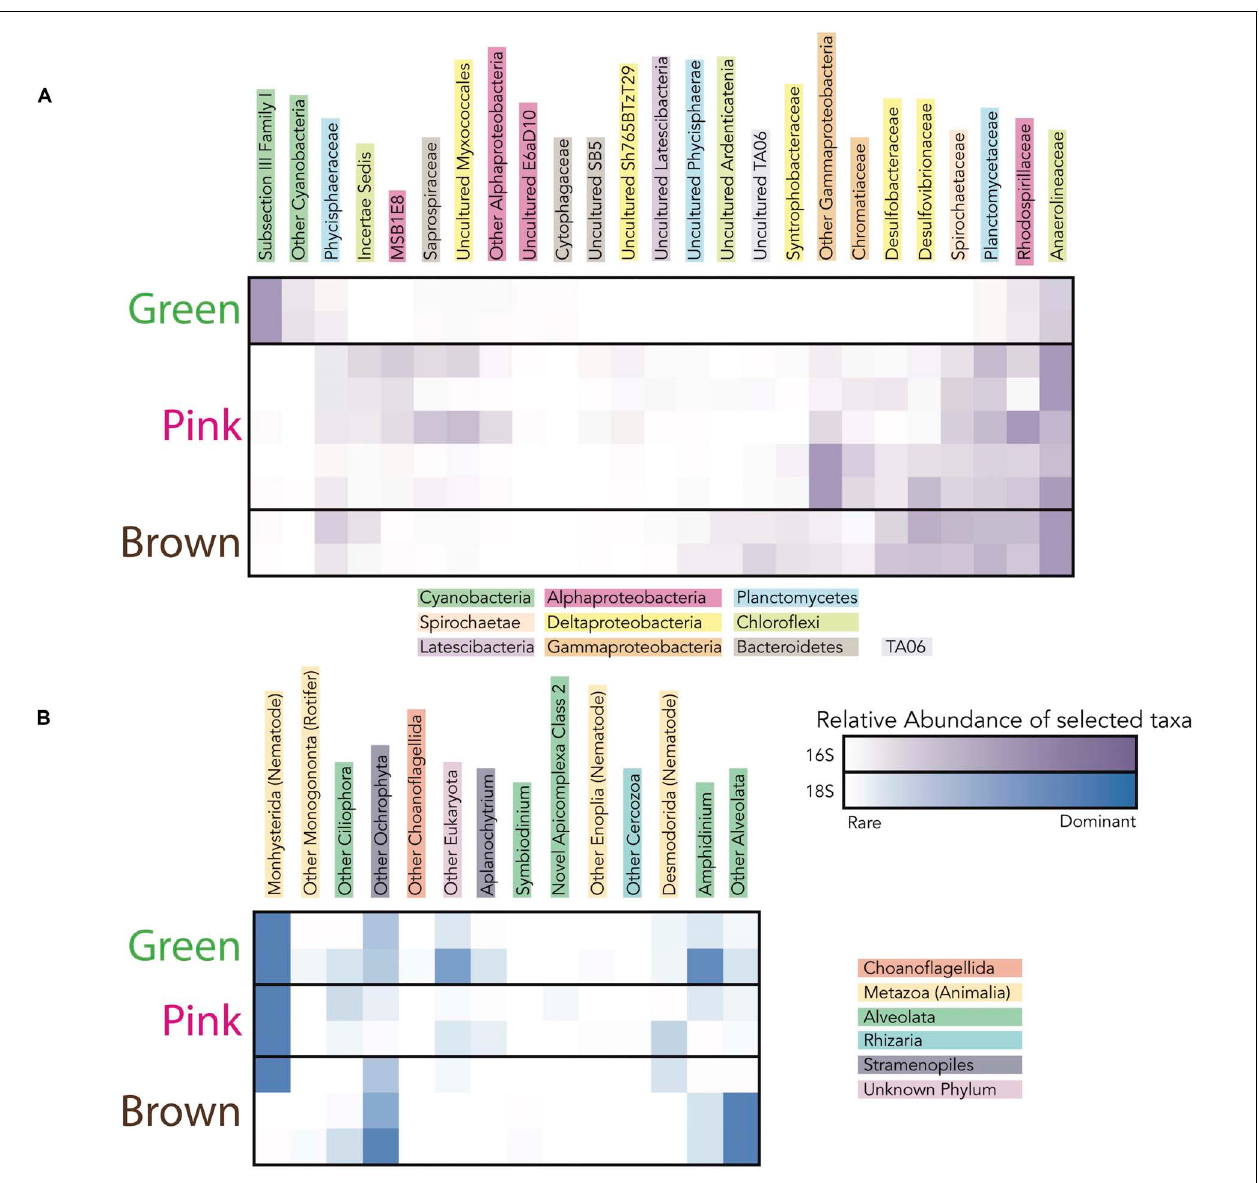
FIGURE 6 | Heatmap showing the taxa (i.e., operational taxonomic units clustered at the 97% level) responsible for the differences in microbial community diversity between the green, pink, and brown layers in sites CC1 and F6 from (A) 16S rRNA gene data and (B) 18S rRNA gene data. Families included in heatmaps have maximum relative abundance in any sample ≥ 1% of total community and represented families responsible for 95% of variance (calculated using simper ) between mat layers categorized by color. The darkness of the purple (for 16S rRNA gene data) and blue (for 18S rRNA gene data) colors corresponds to the relative abundance of taxa in each